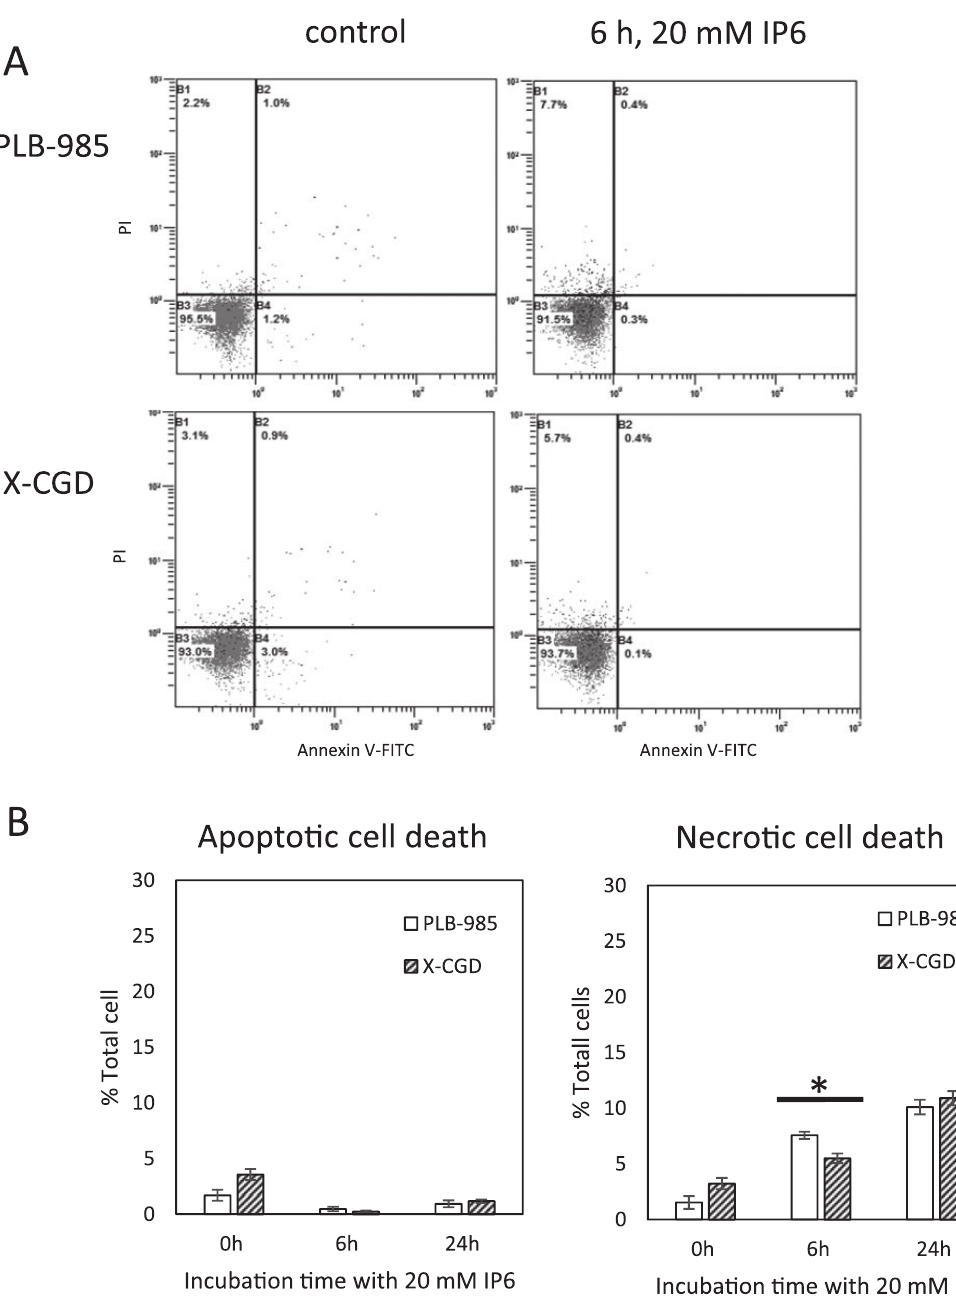
Figure 2 Inositol hexaphosphate -induced cell death Inositol hexaphosphate (IP6)-treated cells were analyzed with flow cytometry using Annexin V-Fluorescein isothiocyanate (FITC)/propidium iodide (PI). A) Typical flow cytometry pattern of IP6-treated cells using the dot plot with Annexin V-FITC on the X-axis versus PI on the Y-axis. B) rate of apoptotic and necrotic cell death obtained from three independent experiments. *P<0.05 (Student’s